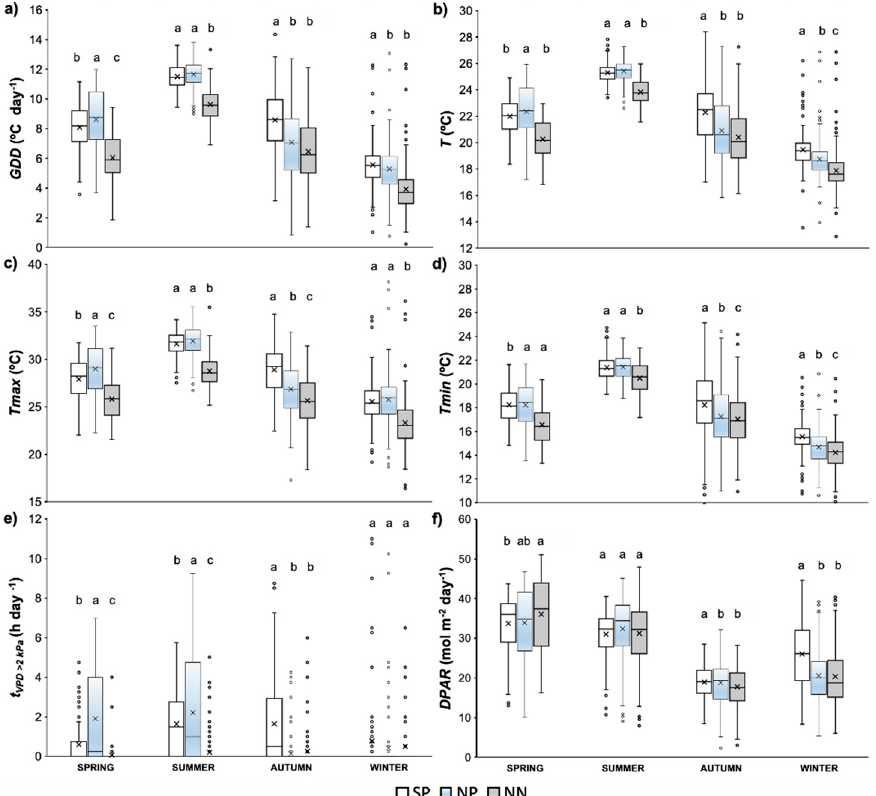
Figure 1. Meteorological variables from April 2015 to March 2017 inside the papaya ( Carica papaya L. cv. Sweet Mary) greenhouses (SP and NP) and the screenhouse (NN): ( a ) GDD (growing degree days); ( b ) T (air temperature); ( c ) Tmax (maximum air temperature); ( d ) Tmin (minimum air temperature); ( e ) t VPD > 2kPa (daily total time (h) with vapor pressure deficit conditions above 2 kPa); and ( f ) DPAR (total daily photosynthetically active radiation). The boxes are bounded on the top by the third quartile, and on the bottom by the first quartile. The median divides the box and the (x) represents the mean. The whiskers are error bars: one extends to the maximum and the other to the minimum. Any point outside ( ○ ) these whiskers is considered an outlier. Boxplots followed by the same letter are not significantly different according to the LSD test at a significance level of 0.05.